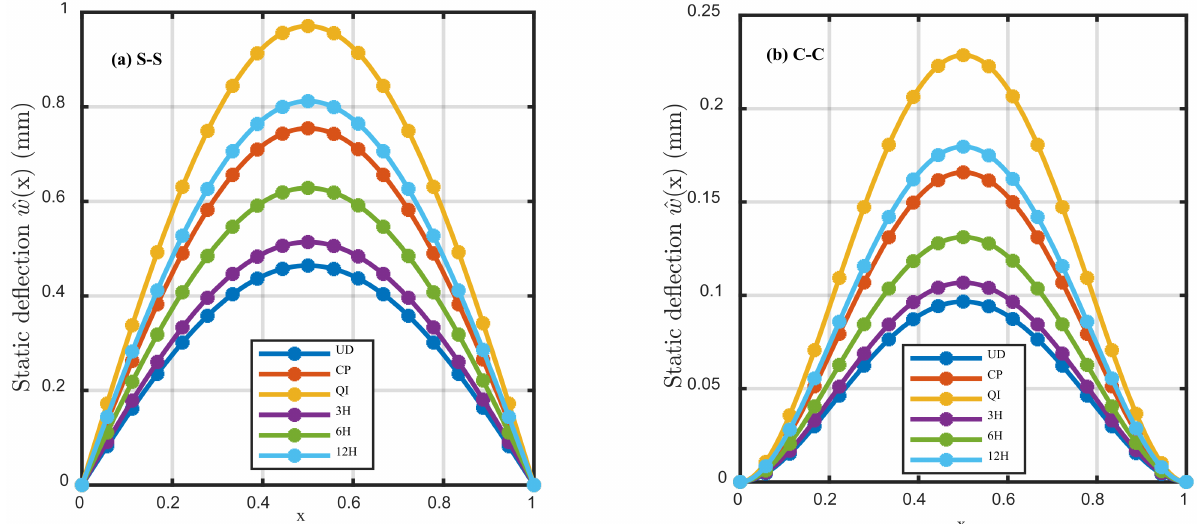
Figure 3. The nonlinear bending deflection of the S–S and C–C perfect composite beams subjected to uniform load with different layup sequences ( L = 100 h , k s = k L = 0, A 0 = 0, ˆ q 0 = 5 N / m ) .